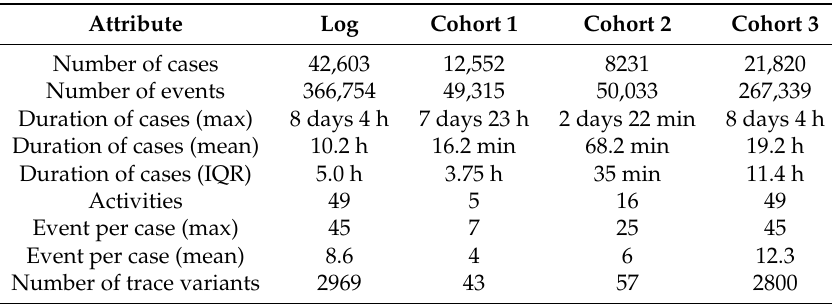
Table 2. Event log and cohort